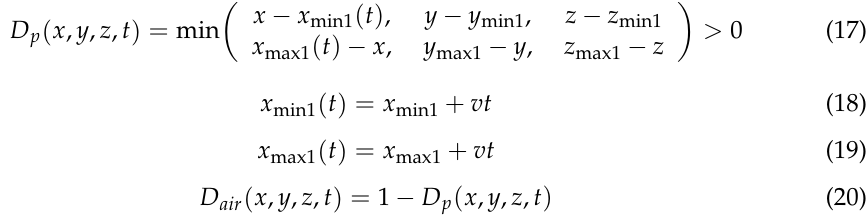
After setting the implicit function of each physical region, Equation (1) is solved in